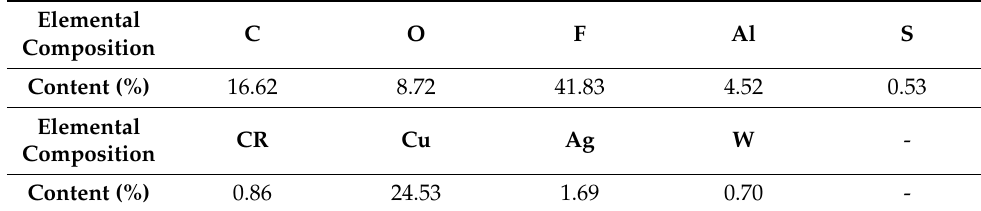
Table 3. Comparison of sample test results of test circuit breakers. (a) Content detected by field emission electron microscope (%)